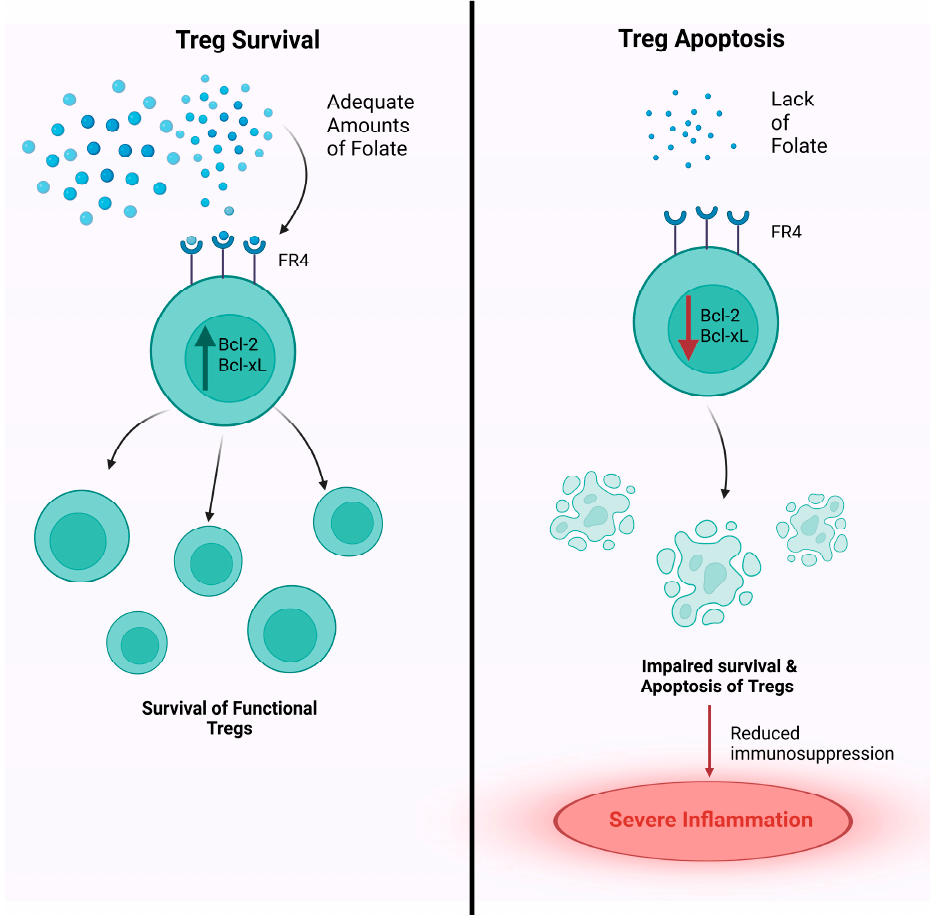
Figure 2. Folate is required for the survival of mature Tregs . Once naïve T cells differentiate into Tregs, they highly express folate receptor 4 (FR4), which regulates the development and function of Tregs. The binding of folate to FR4 stimulates the production of the anti-apoptotic molecules Bcl-2 and bcl-xL, allowing for the survival of functional Tregs. Folate deficiency affects the survival of Tregs, leading to a reduction Bcl-2 and Bcl-xL and hence, an increase in Treg apoptosis. Impaired Treg function may impair immunosuppression and lead to increased susceptibility to intestinal in- flammation .